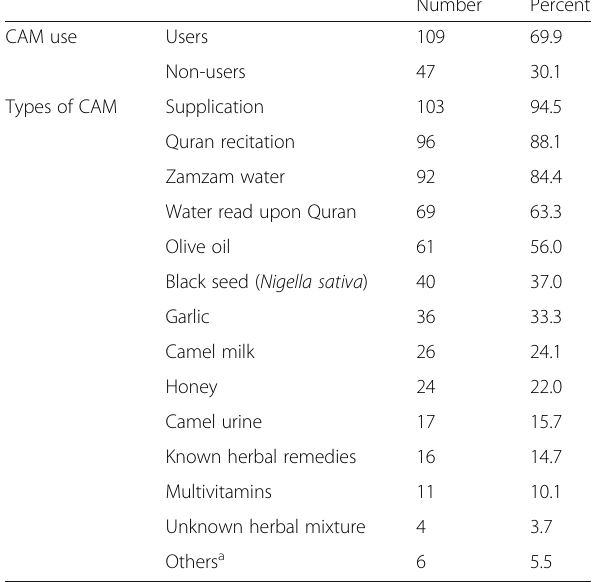
Table 2 Frequency of use of different types of complementary and alternative medicine (CAM)